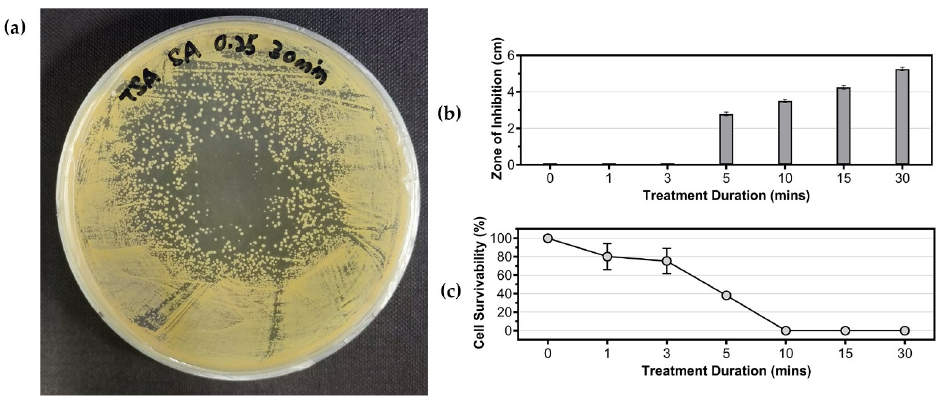
Figure 3. Effects of cold plasma treatment on the growth of Staphylococcus aureus ATCC 6538. ( a ) Example of inhibition zone formation on the S. aureus spread plate; ( b ) effect of cold plasma treatment duration on zone of inhibition formed on agar plates; ( c ) cell survivability of S. aureus in liquid suspension after treatment with cold plasma.